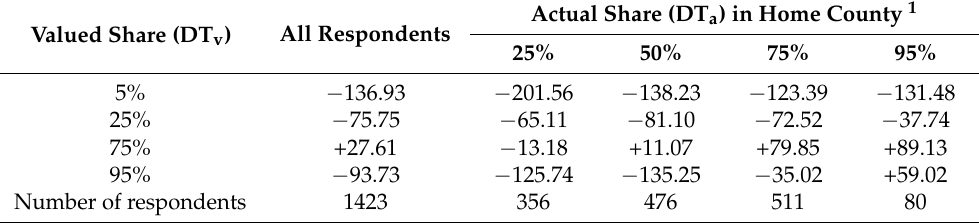
Table 4. Willingness to pay (WTP) for different shares of deciduous trees (DT v ) in € per household and year, depending on actual share of deciduous trees in home county (DT a ), according to